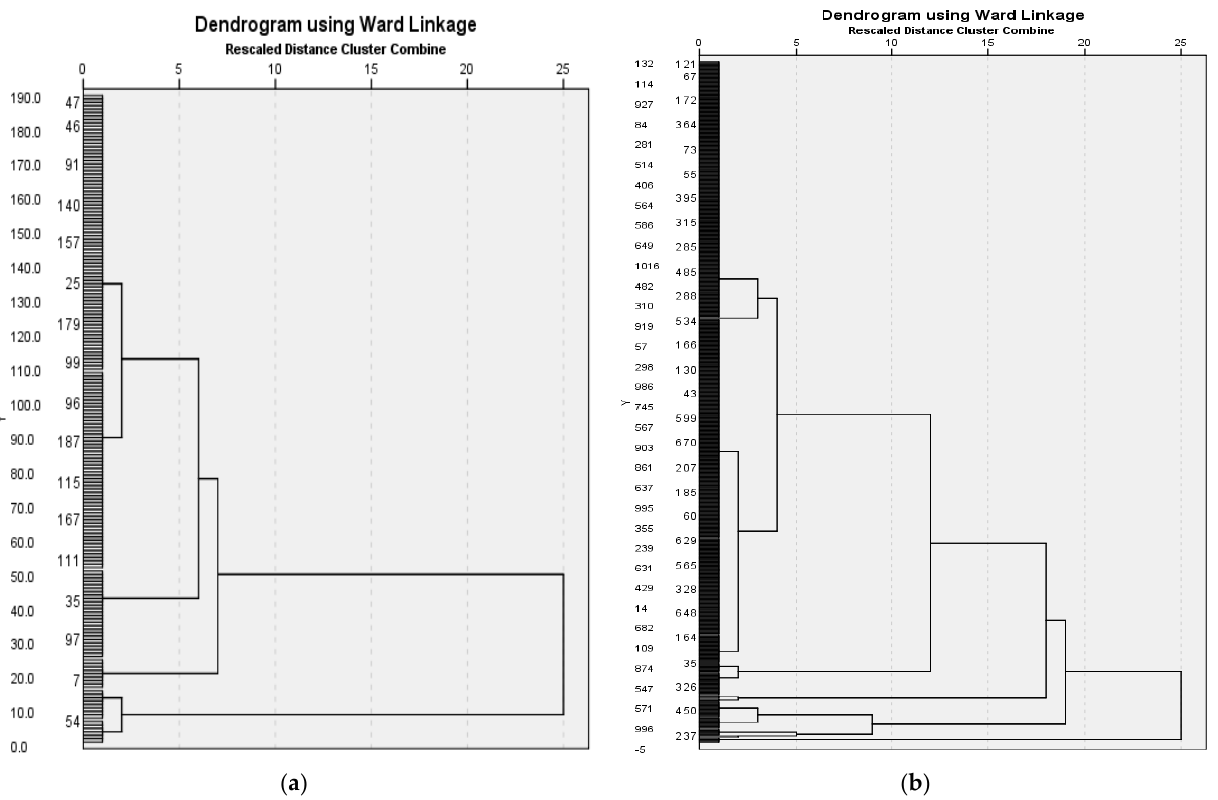
Figure 5. ( a ) Dendrogram using Ward Linkage method for Hungarian database. ( b ) Dendrogram using Ward Linkage method for Romanian database. Source: Authors’ own editing, based on own calculations.